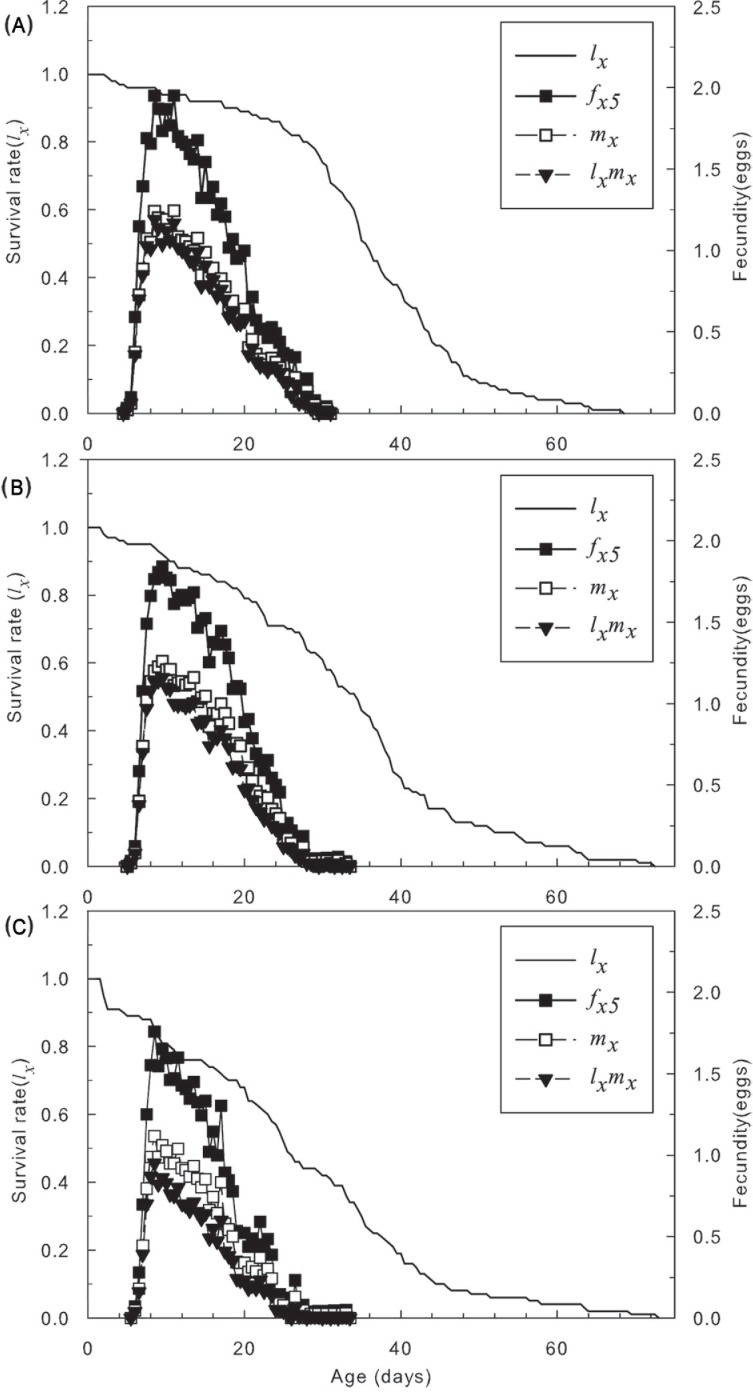
Age-stage specific survival rate (sxj) of offspring from adult female N. californicus (McGregor) fed on T. cinnabarinus treated with sublethal concentrations of SYP-9625.(A) Control, (B) LC10, (C) LC30.